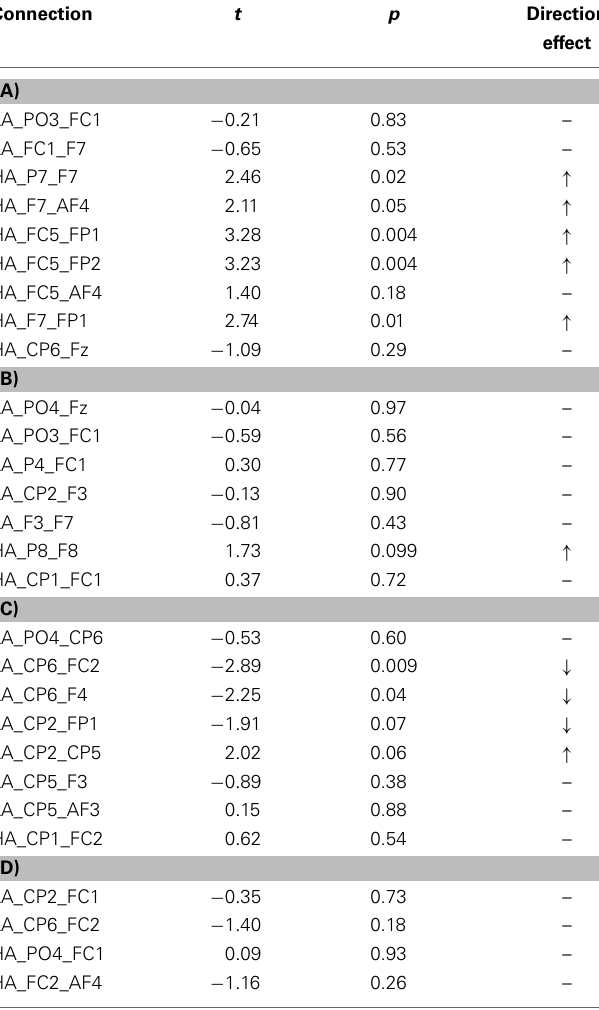
Only connections between parietal and frontal electrodes (based on positions in the international 10/20 system) with robust significant PLI group differences are shown (i.e., solid lines in Figure 3 ). The arrows represent the direction of the information flow between the two nodes (i.e., electrodes) specified in the contrast. Upward arrows indicate that the first node is sending information to the second node, whereas downward arrows indicate that the first node is receiving information of the second node. Arrows are presented for p-values <